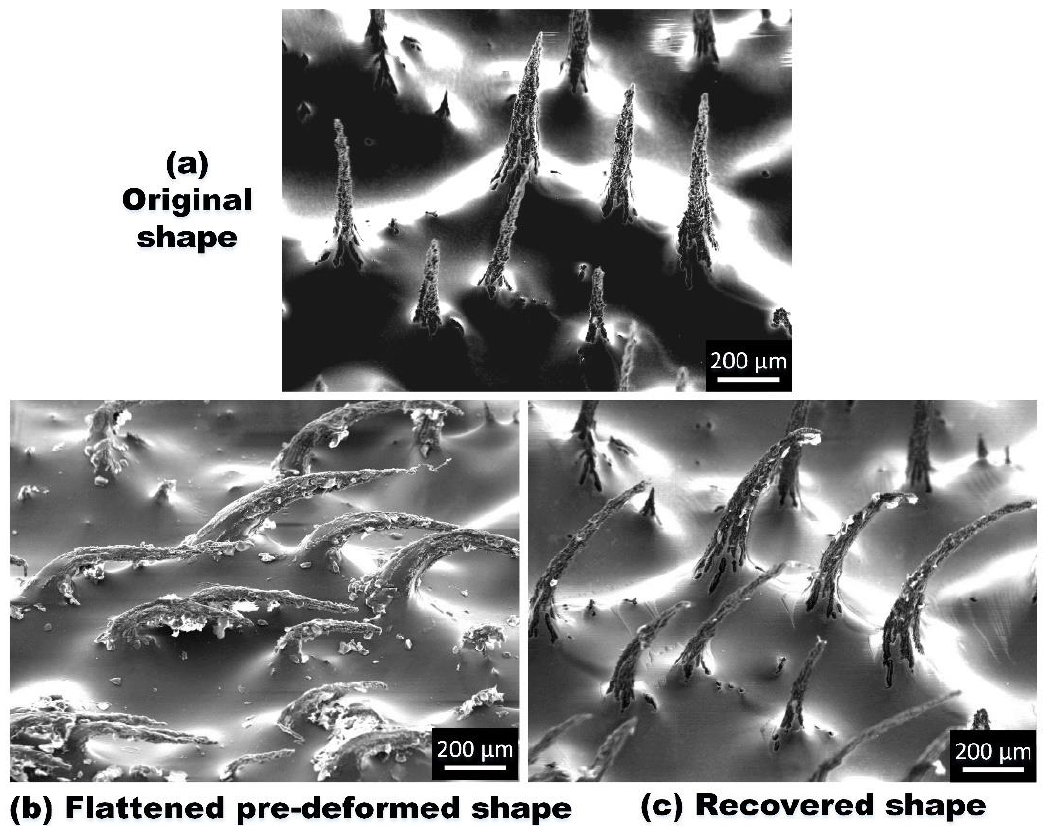
Figure 10. Typical shape recovery cycle of the vertical protrusive Shape Memory Polymer / Nickel (SMP / Ni) chains (2 vol% Ni). ( a ) Original shape; ( b ) Flattened pre-deformed shape; ( c ) Recovered shape.